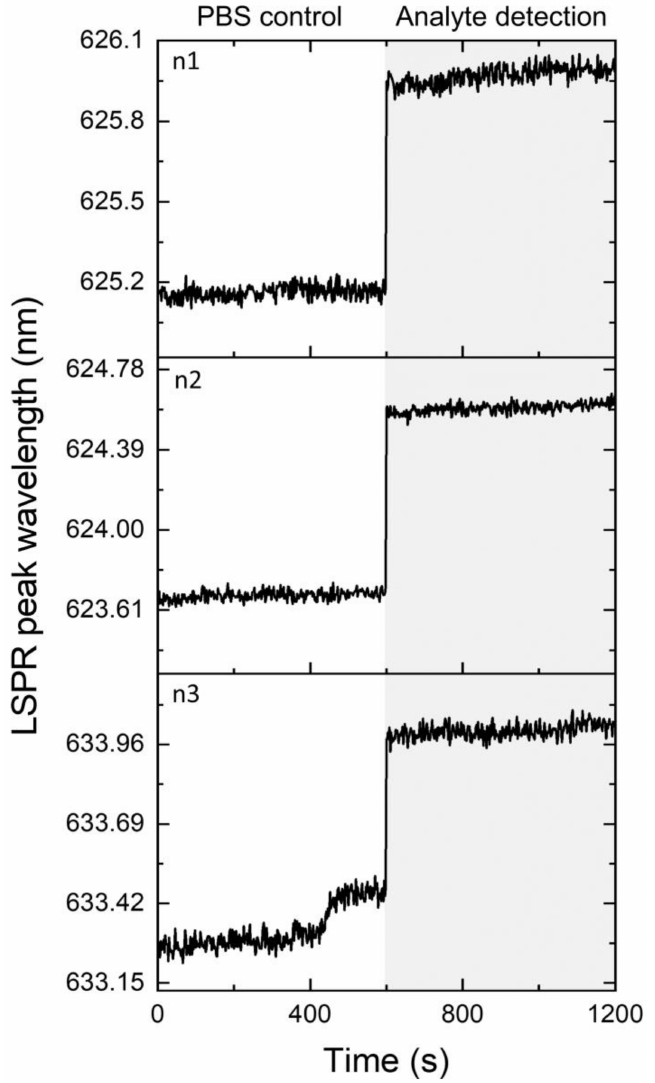
Figure 7. Ten-minute LSPR peak wavelength monitoring of the produced Au-TiO 2 biosensor after in- cubation with PBS (control) and after the incubation with 13.5 µ g/mL biotin–HRP (analyte detection). n1, n2, and n3 are the three independent samples